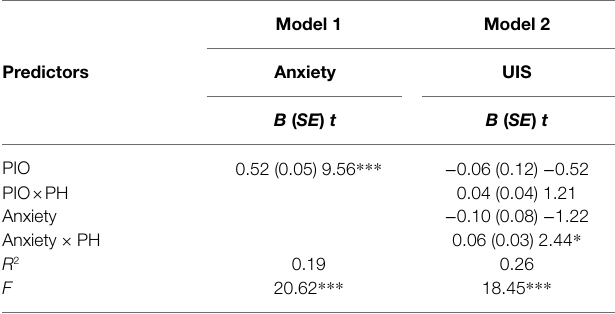
TABLE 4 | Testing the moderated mediation